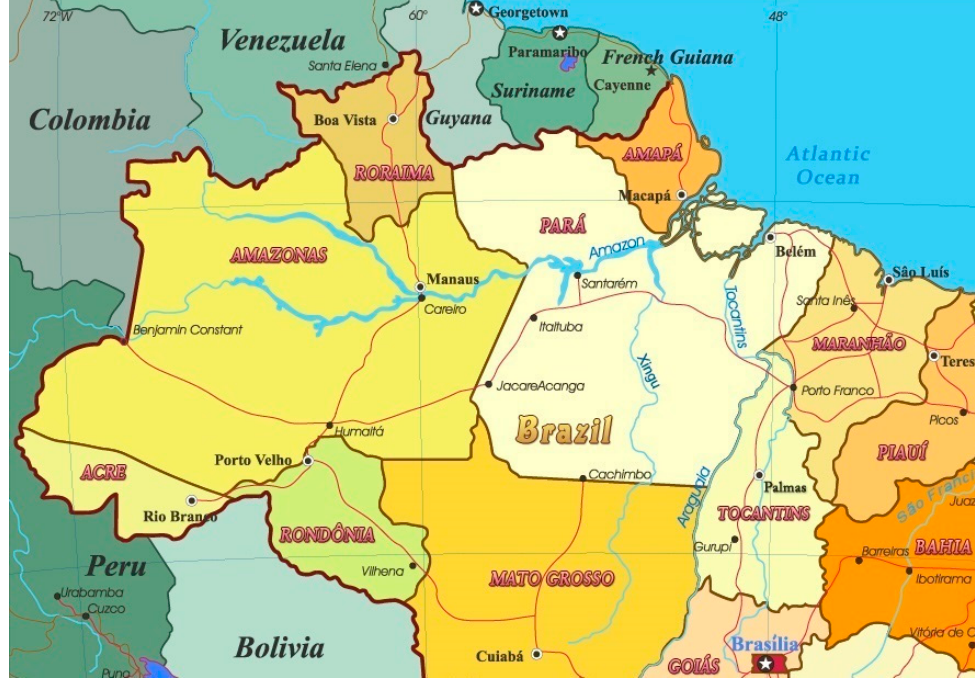
Figure 1. Map of the states of Amazonas and Pará in Brazil and their neighboring states and international borders. Reproduced from http://www.geographicguide.net/america/brazil-map.htm (accessed on 15 February 2021)—Adapted with permission from copyright © Geographic Guide— World in Pictures.